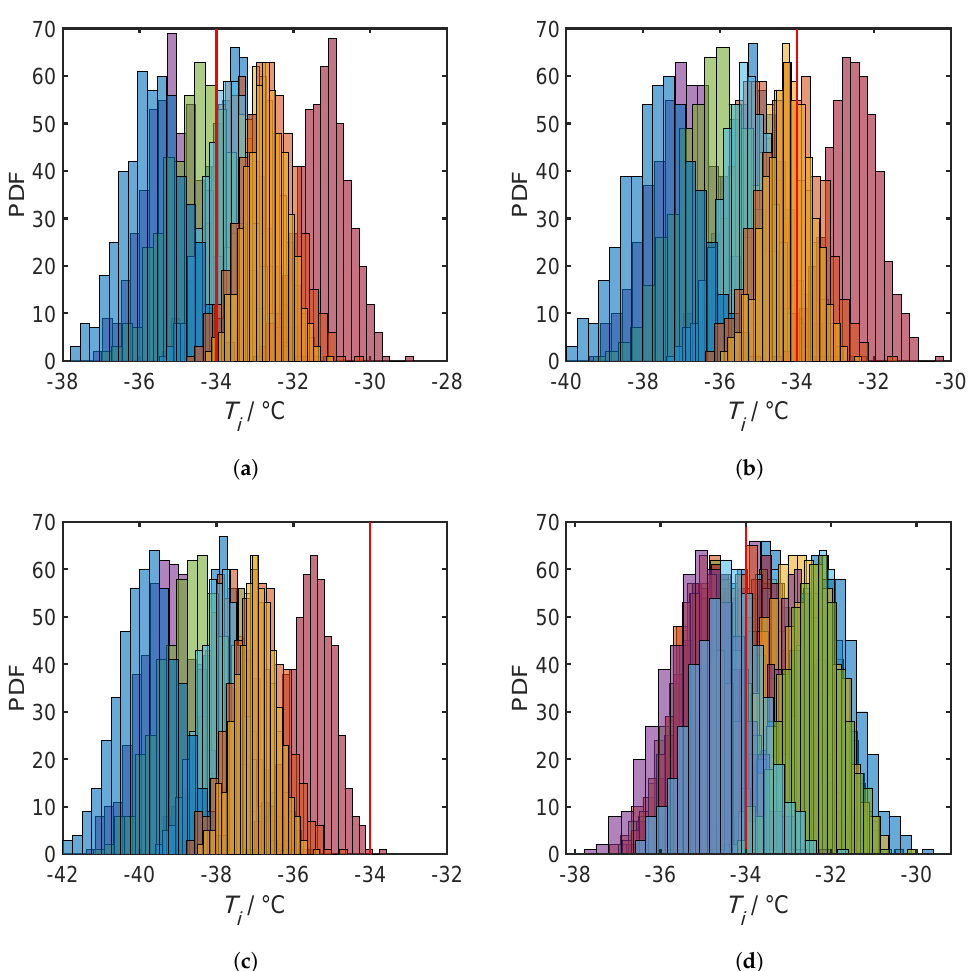
Figure 5. Probability density functions of the temperature at the sublimation interface ( T i ) obtained from different probability distributions of parameter uncertainties for ( a ) nominal, ( b ) robust, ( c ) p-box robust (plausibility function), and ( d ) p-box robust (belief function) process designs. The red line is the upper limit of T i